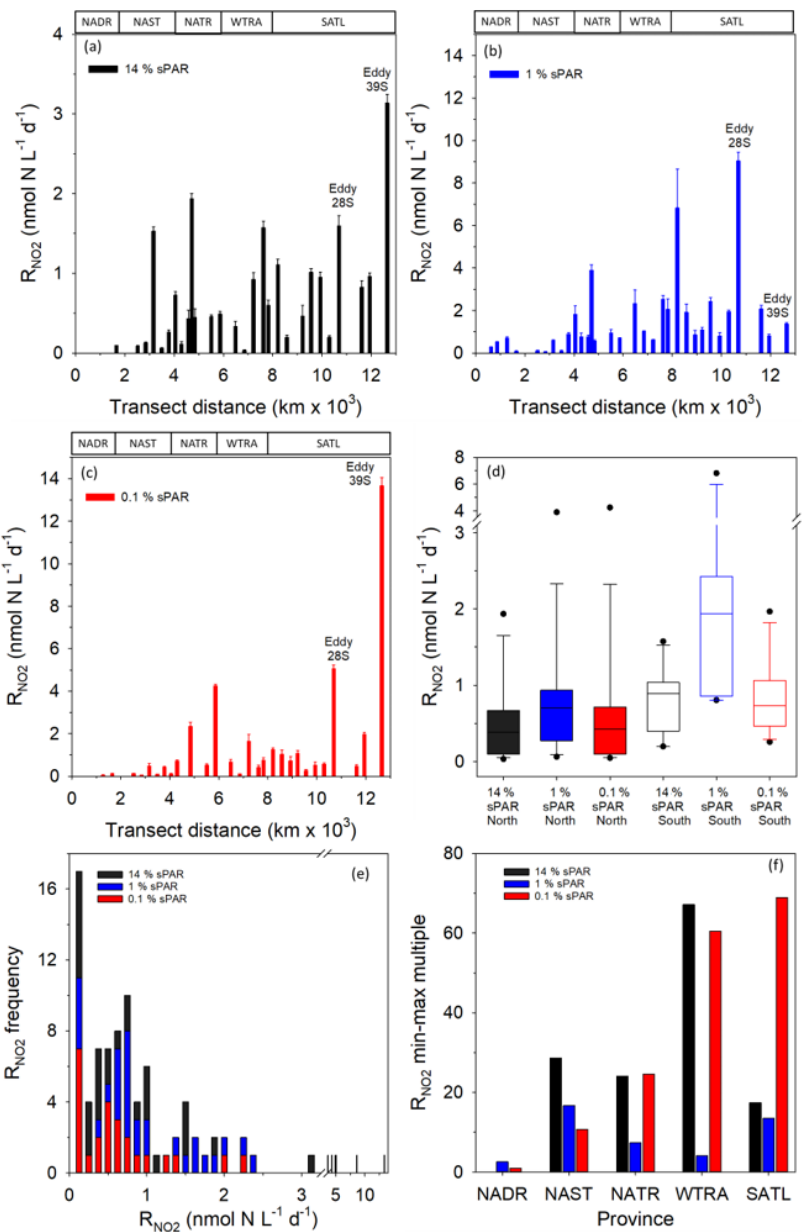
Figure 7. Volumetric rates of NO − regeneration at 14% (a) , 1% (b) , and 0.1% (c) sPAR. Error bars represent 2 standard deviations of 2 triplicate measurements. The approximate positions of Longhurst provinces (defined in Fig. 1) are identified in these plots. The box plot (d) presents data for each hemisphere (excluding 28/39 ◦ S) as sPAR depths. The 10th, 25th, 75th, and 90th data percentiles are presented with the data median (line within the box). A histogram of the rate distribution and frequency is presented in (e) . An indication of R NO variability is presented in (f) as the number of minimum-value multiples that equate to the largest value within each